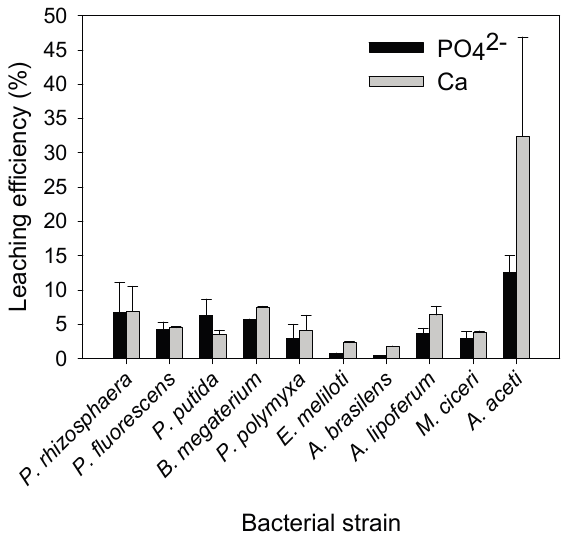
Figure 1. Phosphate and calcium solubilization from Ca 3 (PO 4 ) 2 in Reyes basal liquid medium, associated with microbial growth after 3